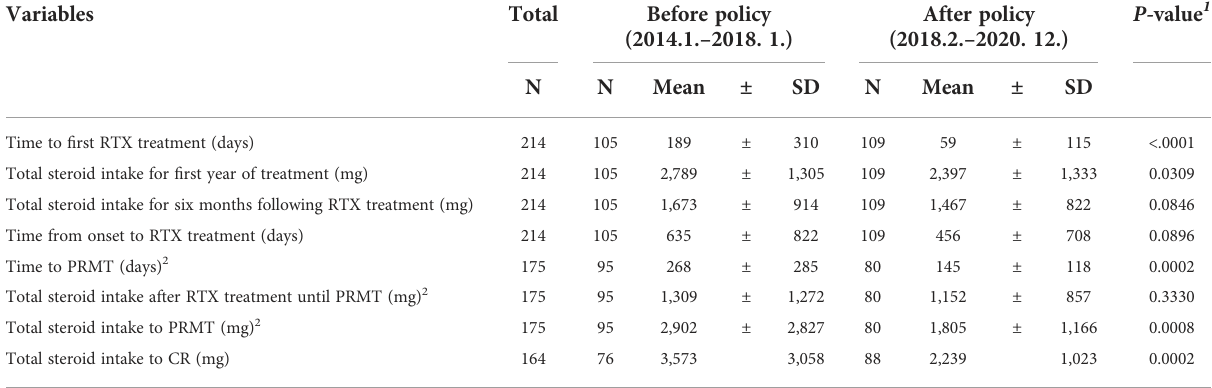
TABLE 2 Changes in clinical outcomes before and after the implementation of the rituximab reimbursement policy. Variables Total